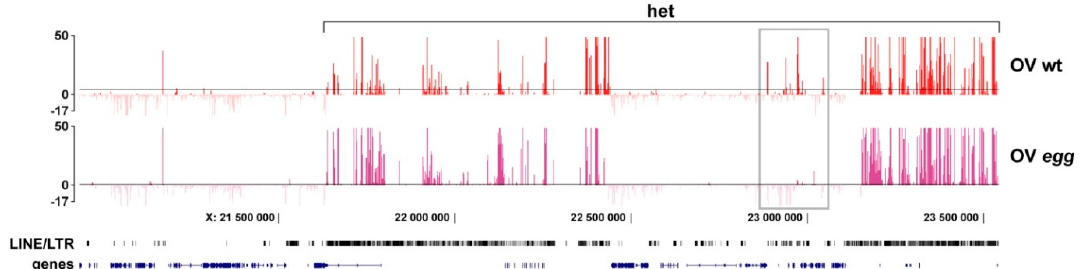
Figure 3. SU(VAR)3-9 profiles for the pericentric heterochromatin of the X chromosome (het) in the germline cells of the wild type (OV wt) and egg mutant females (OV egg ). Single copy heterochromatin-resident genes featuring SETDB1-dependent SU(VAR)3-9 binding are highlighted by the grey frame. The density of grey and black vertical lines on the LINE / LTR panel visualizes the density of various repeated DNA sequences. Axis labels are the same as in Figure 2.